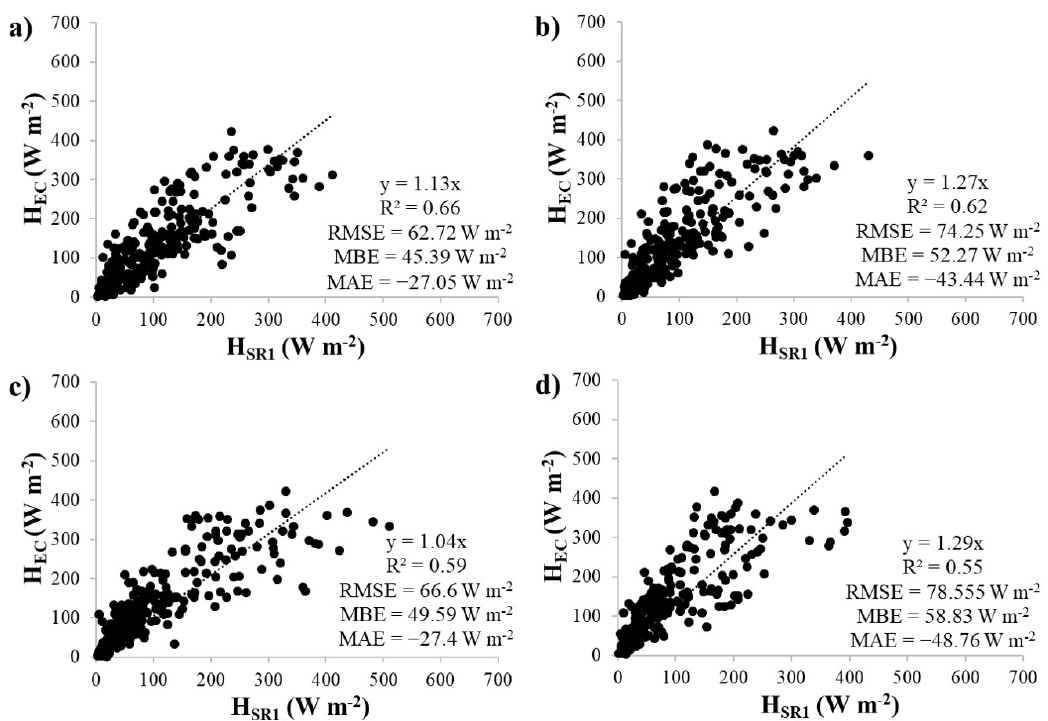
Figure 4. Linear regression analysis between H SR1 and H EC at the cut plot for the upper thermocouple using time lags of ( a ) 0.4 s and ( b ) 0.8 s and the lower thermocouple using time lags of ( c ) 0.4 s and ( d ) 0.8 s.